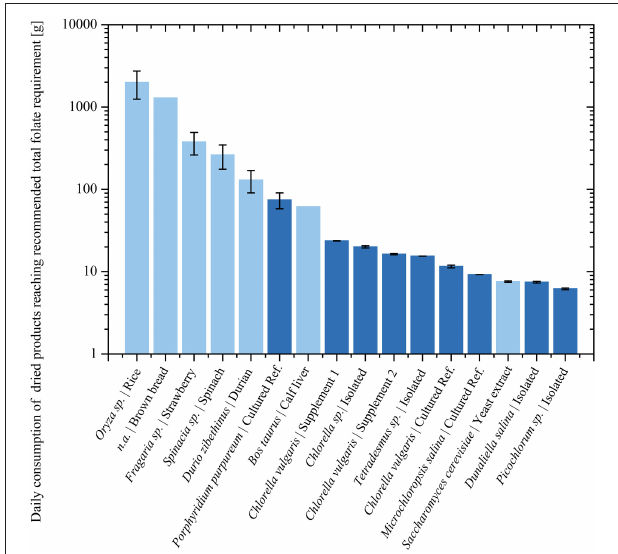
FIGURE 6 | Analyzed food products during this (Dark blue) and previous (Light blue) studies. Required biomass consumption in logarithmic scale according to the U.S. RDA for folate